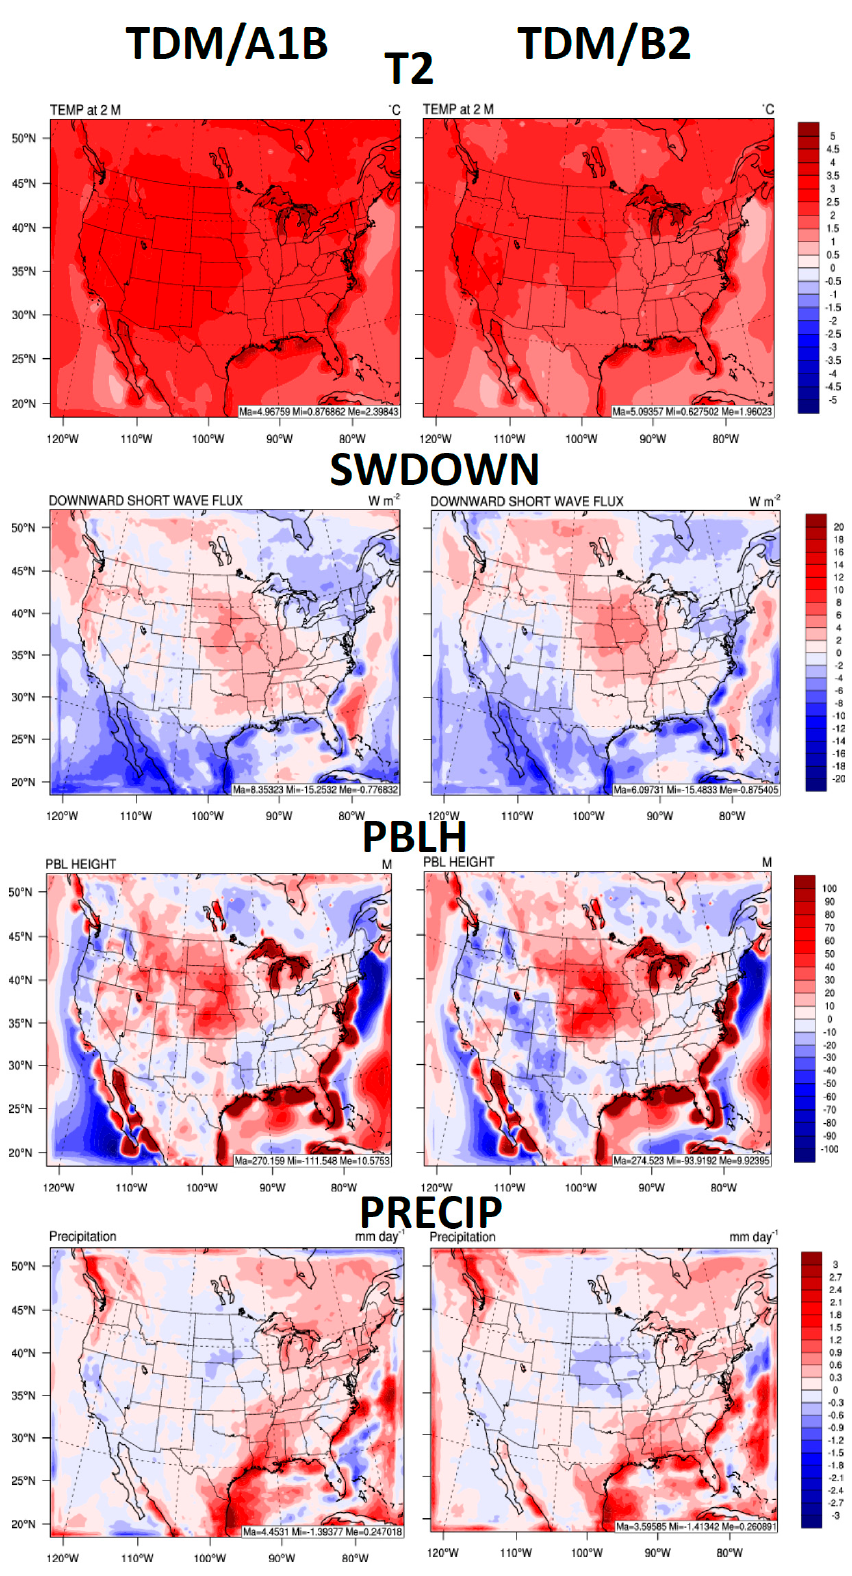
Figure 2. Absolute changes of annual average temperature at 2-m (T2), shortwave downward radiation at the surface (SWDOWN), planetary boundary layer height (PBLH), and total precipitation (PRECIP) between the future and current decade for TDM/A1B ( left ) and TDM/B2 ( right ).